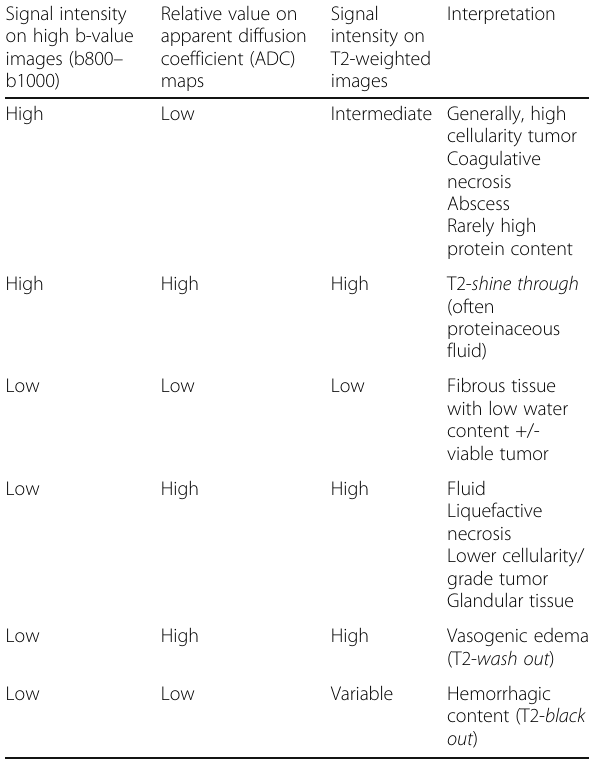
Table 1 Interpretation of tumor diffusion-weighted images Signal intensity on high b-value images (b800 –